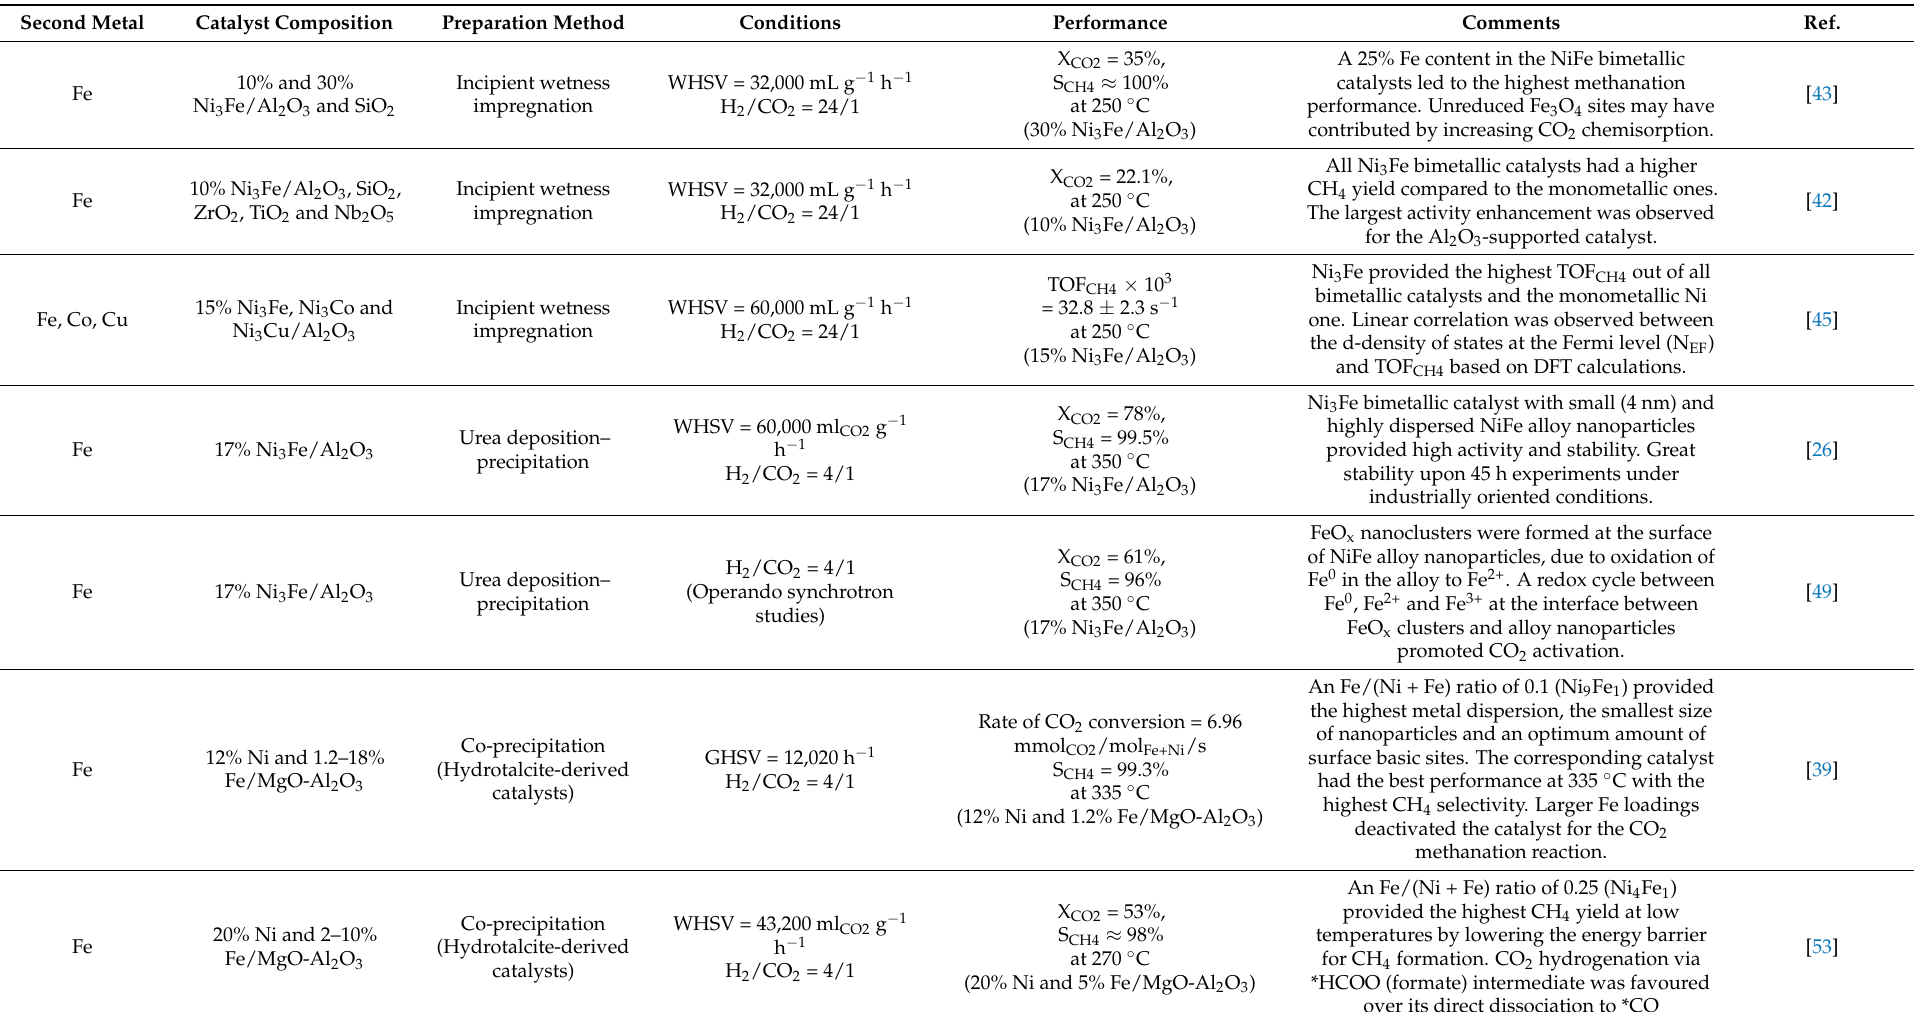
Table 1. Summary of some typical bimetallic Ni-based catalysts promoted with transition metals (Fe, Co and Cu) for the methanation of CO 2